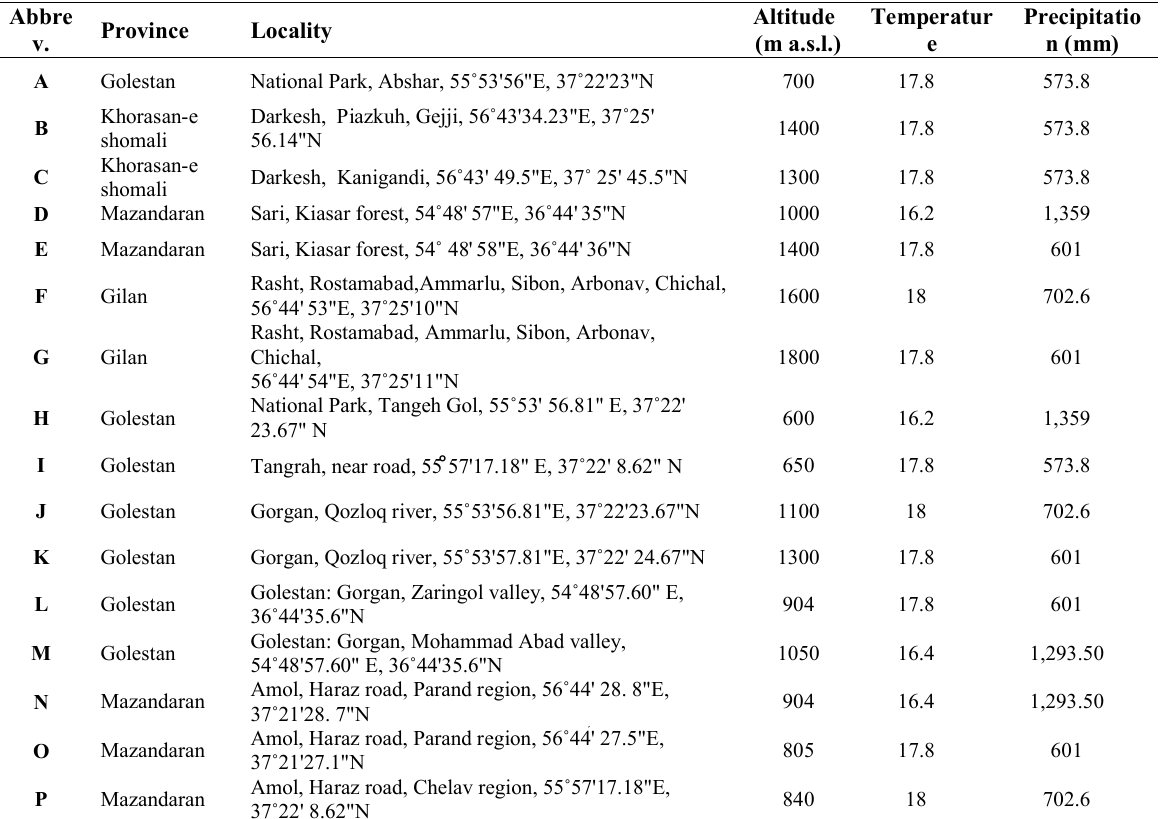
Table 1. Localities and features of each station of Carpinus orientalis population.